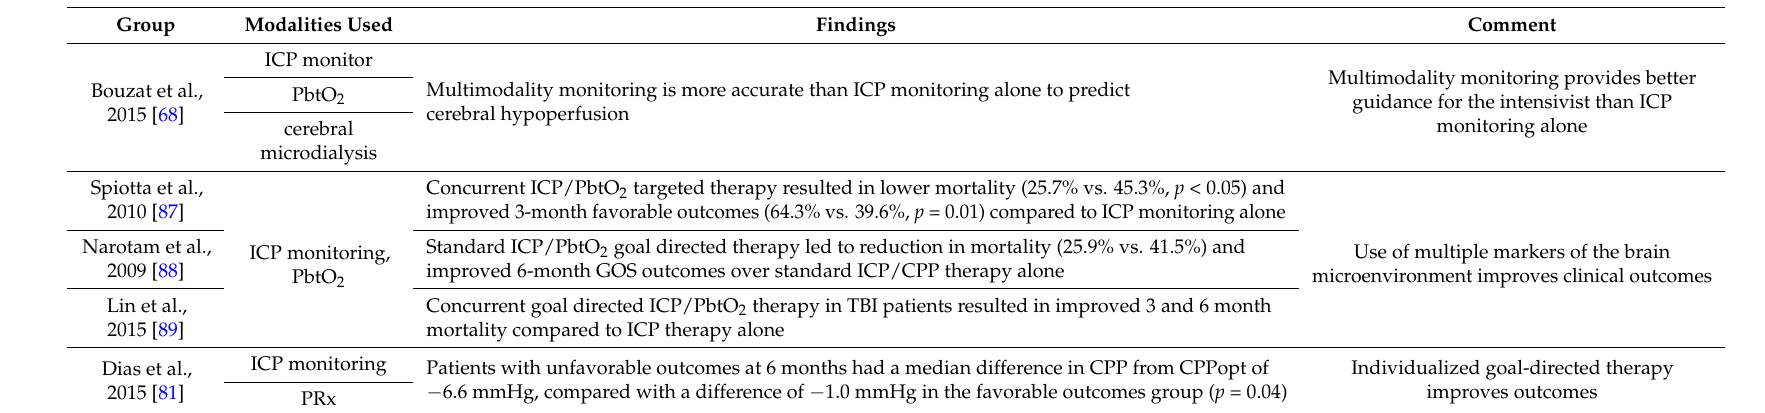
Table 2. Use of multimodality